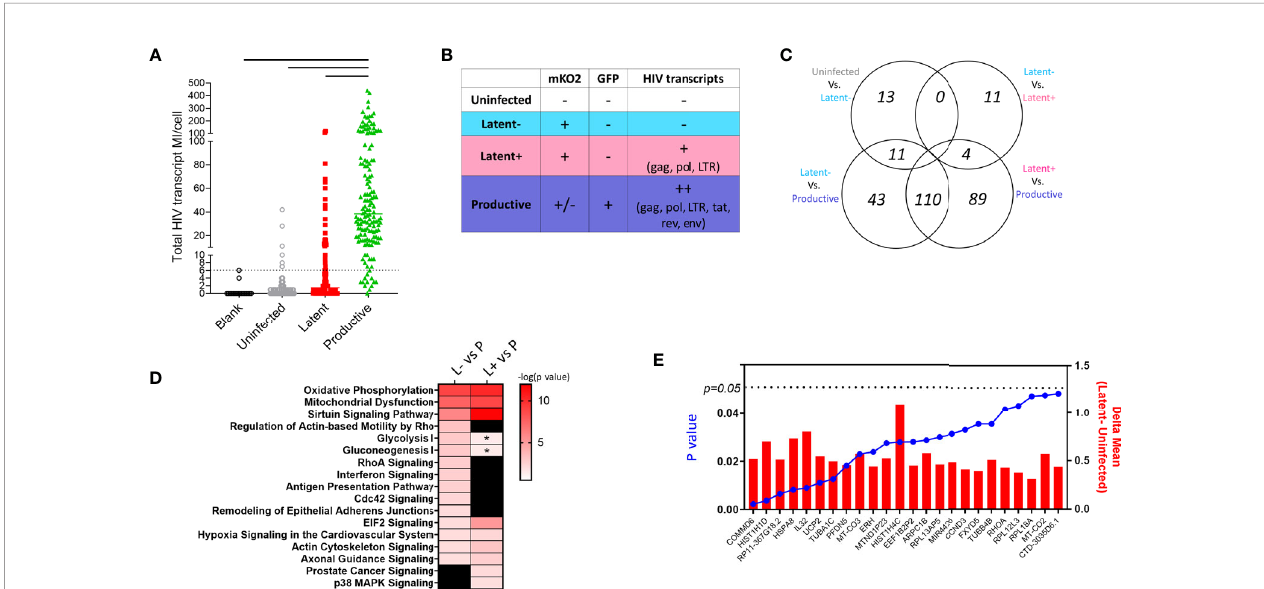
FIGURE 3 | Single cell RNA Seq in HIV GKO model of latency. (A) HIV transcript MI counts per cell in each sorted cell type. Dotted line is cutoff for background levels of transcript expression based on blank control wells in which no cells were sorted. Solid lines indicate signi fi cant difference between productive cells and all other groups using ANOVA one-way test with multiple comparisons (p < 0.05). (B) Schematic showing cell characterization based on fl uorescent reporter and HIV transcript expression. (C) Venn diagram showing number of differentially expressed genes between the cell populations de fi ned in (B) . (D) Heatmap showing shared enriched pathways between Latent cell populations and productive cells. Colored boxes indicate signi fi cant pathways p < 0.01, * indicates pathways with p < 0.05 and > 0.01. (E) Bar graph showing the difference in average expression of each DEG between Latent and Uninfected cells with p values from ANOVA analysis shown as a super-imposed line graph